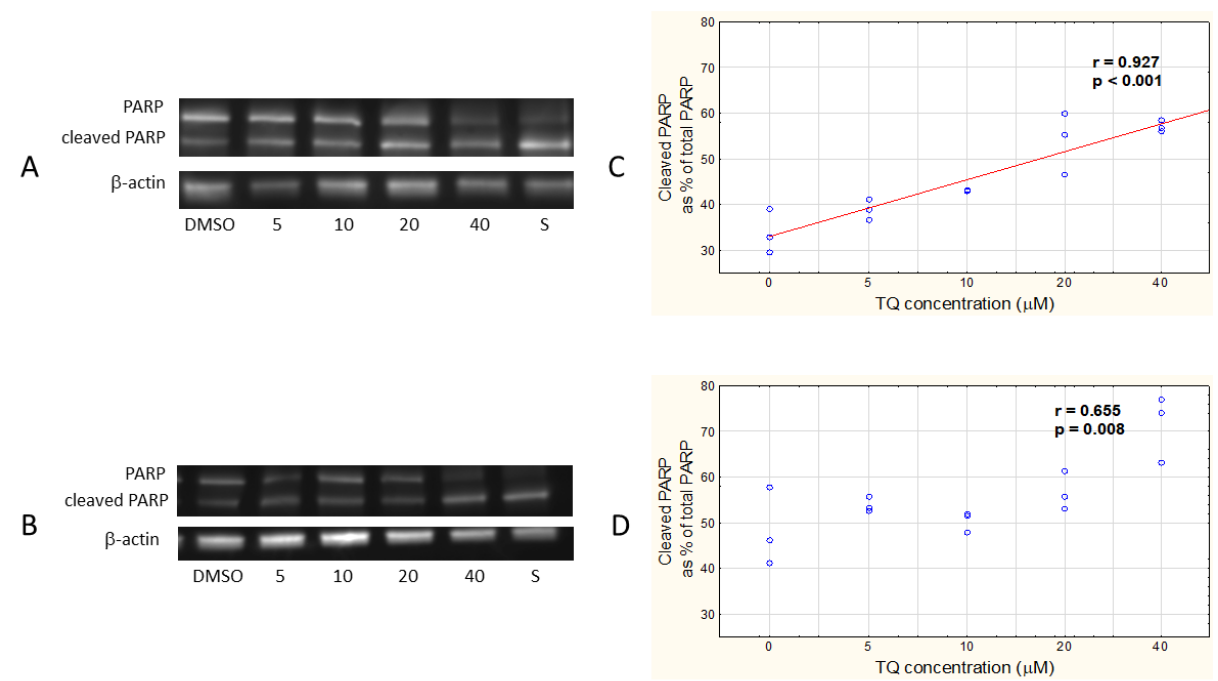
Figure 4. TQ increases the amount of cleaved PARP in A375 and WM9 cells. Expression of PARP detected by Western blot technique in A375 ( A ) and WM9 ( B ) after the treatment with 5, 10, 20, and 40 μ M TQ, and 1 μ M staurosporine (marked as S) for 48 h. Densitometric analysis of Western blot results showing relationship between the free TQ concentration and the amount of cleaved PARP (Spearman correlation analysis) in A375 ( C ) and WM9 cells ( D ). DMSO control shown as 0 μ M TQ concentration; Spearman correlation coefficient (r) and p-value were indicated; data are presented as mean ± SD; p < 0.05 was considered statistically significant.